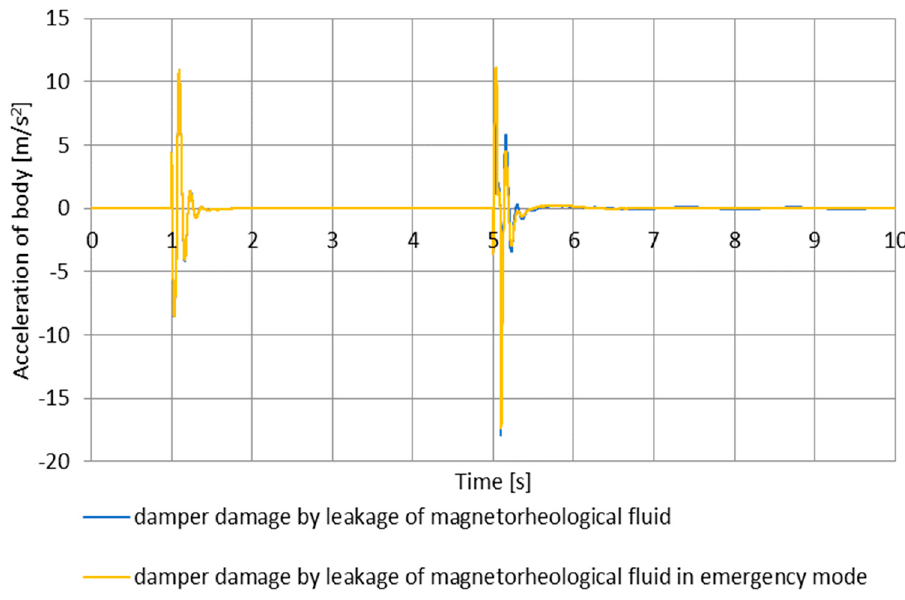
Figure 7. Body vertical acceleration for a damper damaged by magnetorheological fluid leakage with switching into emergency mode.